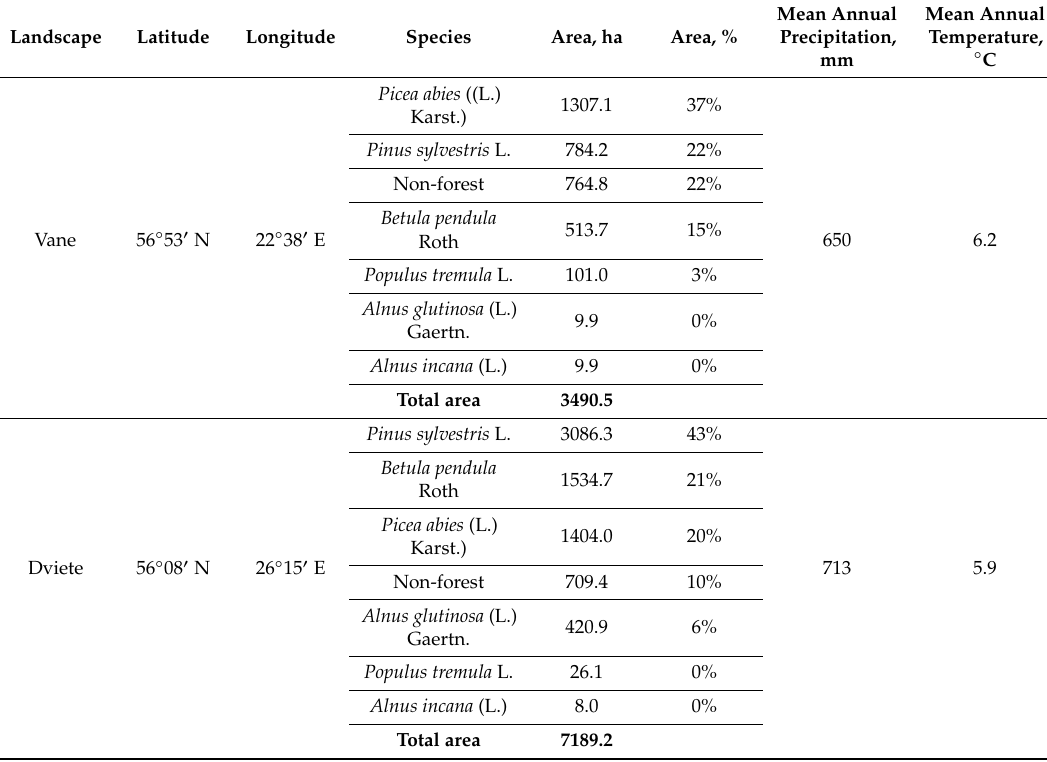
Figure 1. Location of the two study sites in Latvia. Table 1. The characterization of forest massif by dominant species in 1975.